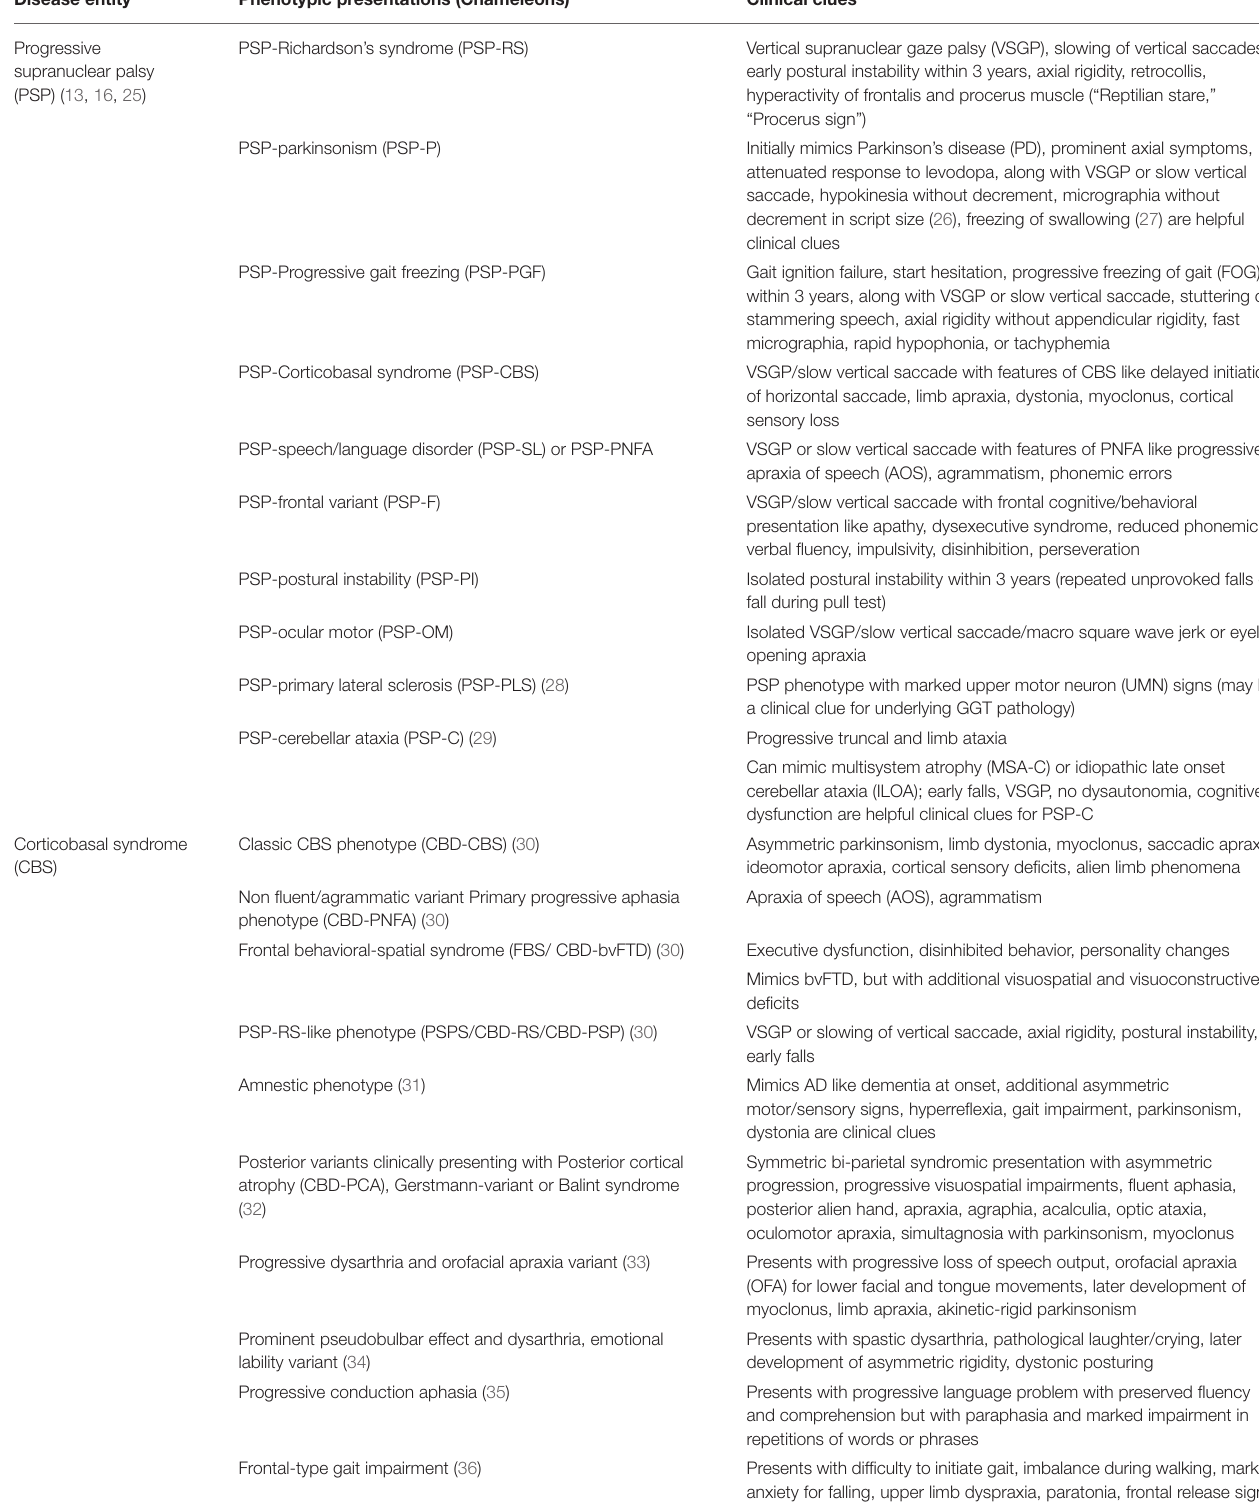
TABLE 1 | Chameleons of PSP and